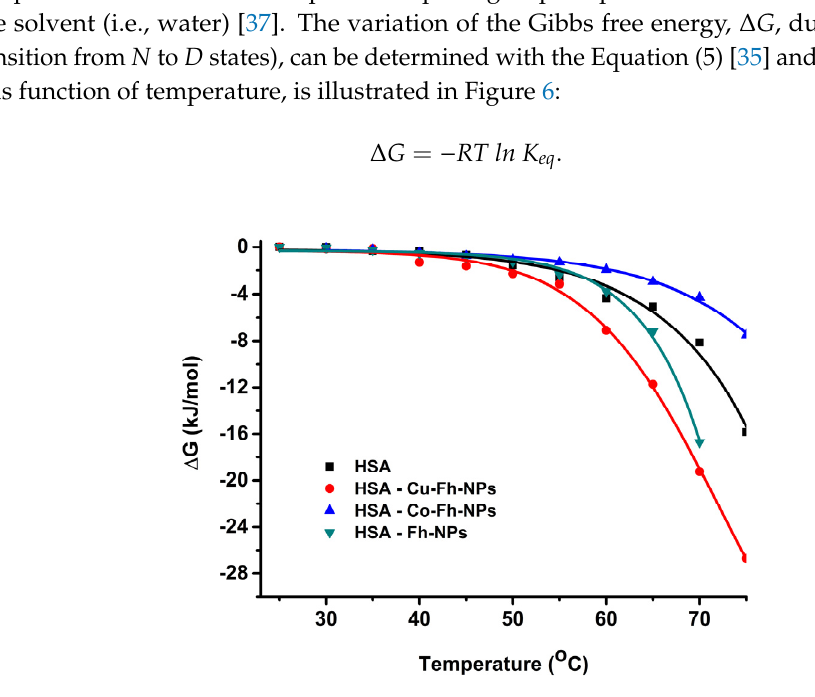
Figure 5. Percentage ( P ) of HSA denaturation as a function of temperature ( left ). Graphical representation for calculation of the HSA denaturation temperature ( right ). HSA ( ■ ), HSA-Fh-NPs ( ▼ ), HSA-Co-Fh-NPs ( ▲ ), and HSA-Cu-Fh-NPs ( ● ). HSA (2.5 µM) was dissolved in 100 mM HEPES, at pH 7.25.